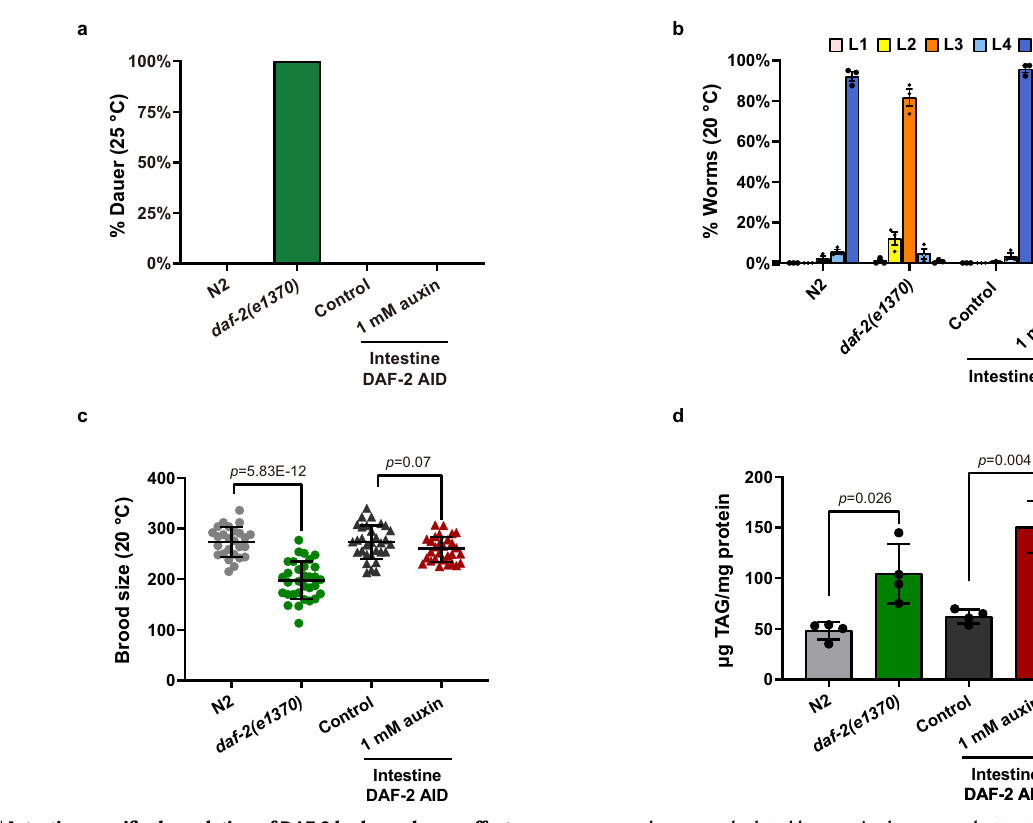
p values are calculated by unpaired two-sample t -test. d Degradation of intestinal DAF-2 elevates the triacylglycerol (TAG) content by 2.4-fold relative to the control animals. Data are representedasmean±SEMof four biologicalreplicates. p values are calculatedby unpaired two-sample t -test. Source data are provided asaSource Data fi